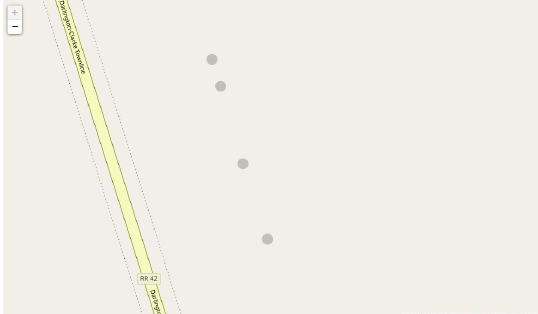
Figure 19. The distance between the containers is uneven, with the last two containers being close to one another. This means that harvesters between the 2nd and 3rd boxes will walk longer distances. There might also be a crowd around the 3rd and 4th boxes as they are fairly close to one